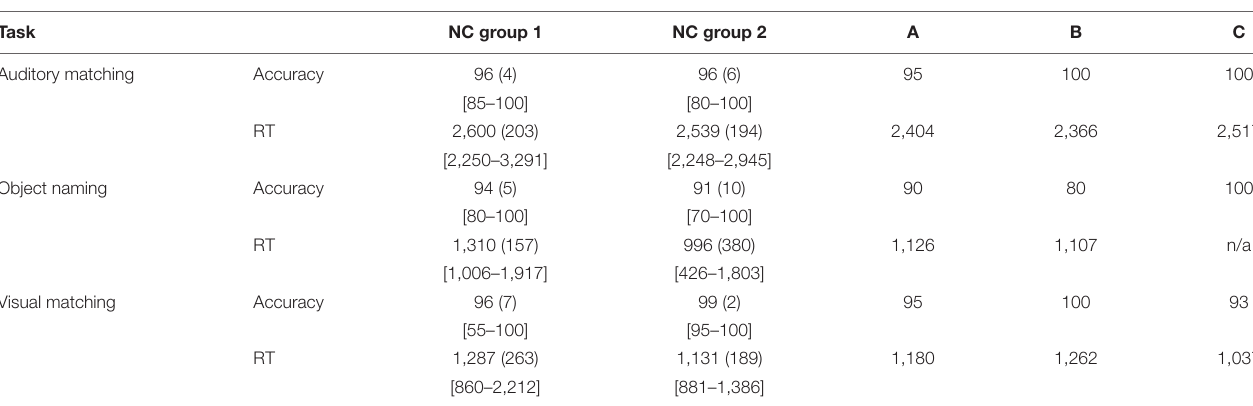
TABLE 4 | In scanner behavioural performance for patients with RpSTS gliomas.